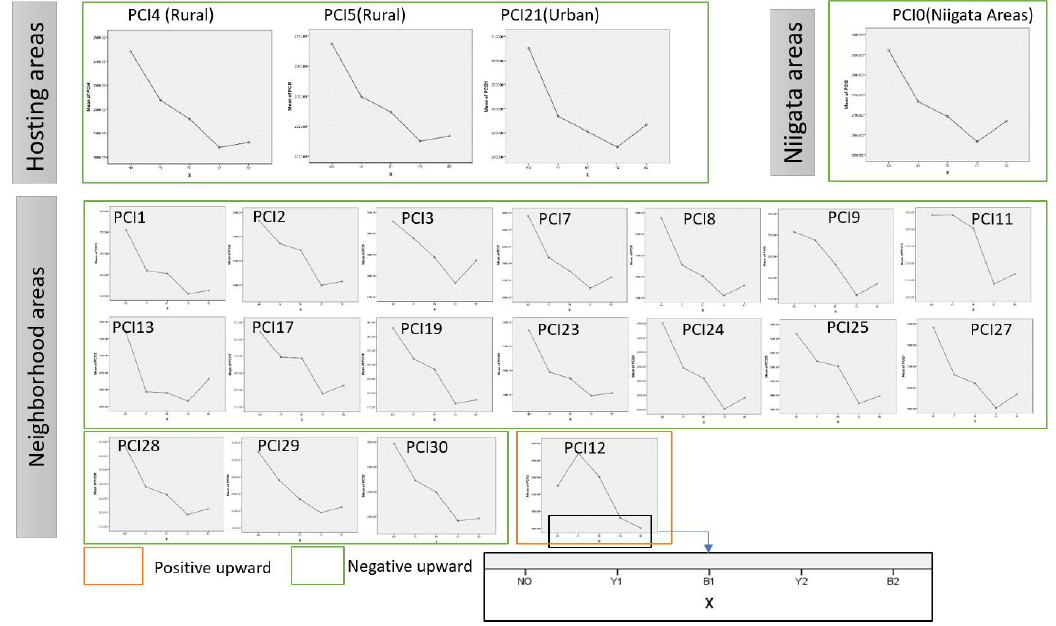
Figure 9. Mean plots (PCI, PCIGR): other areas in Niigata.